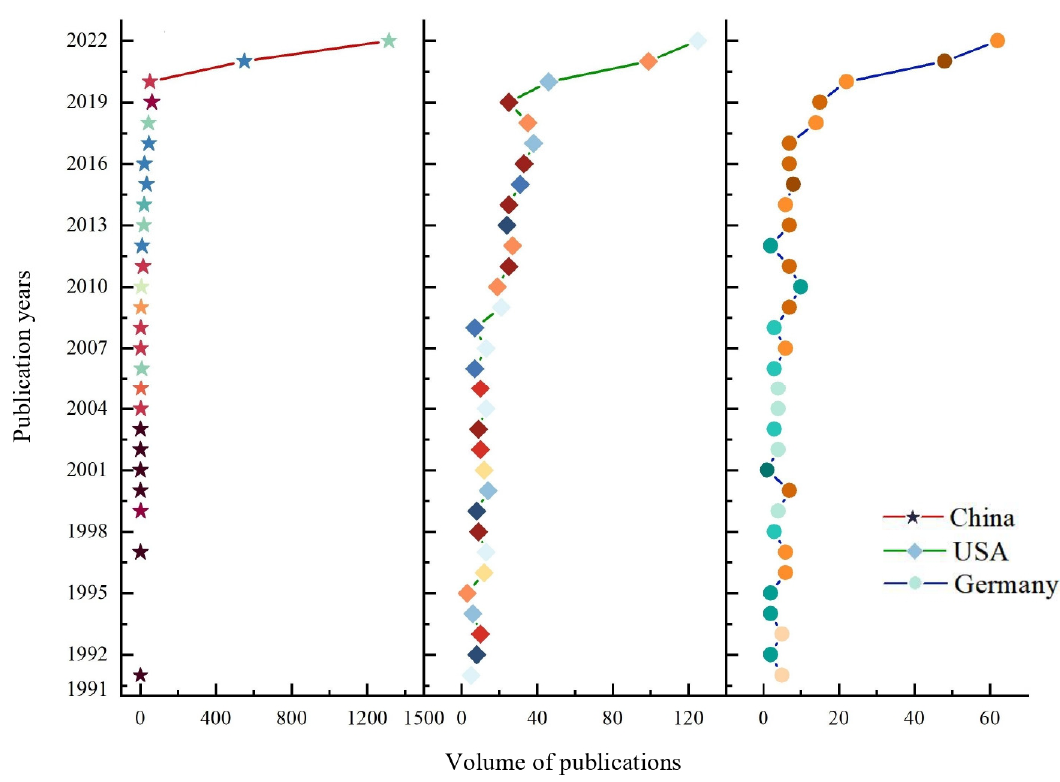
Figure 3. Temporal trends in publications in the top 3 countries (different colors represent differ ‐ ent years).